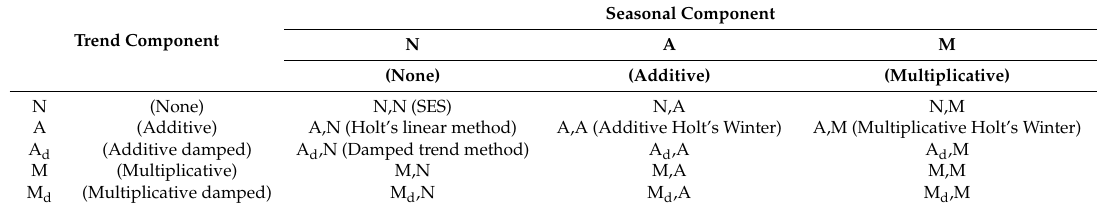
Table 3. Classification of fifteen exponential smoothing methods, by Taylor (2003)